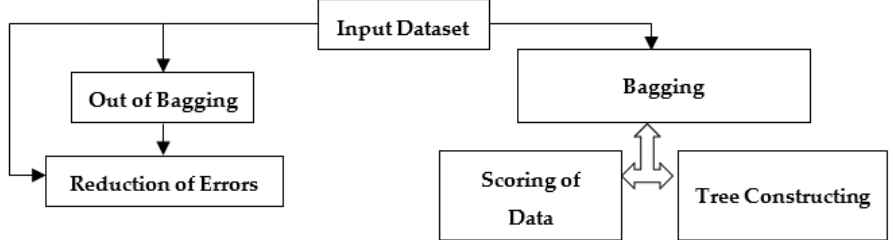
Figure 1. Basic structure of decision tree.